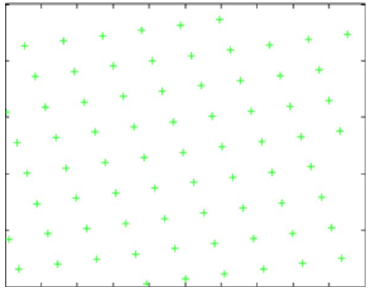
Figure 9: 74 GCPs of self-calibration